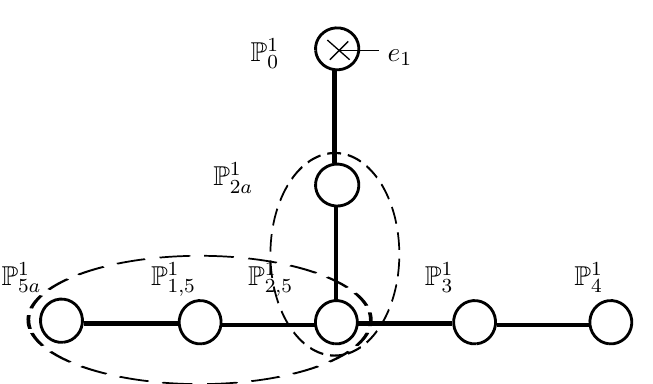
Figure 7 . Extended Dynkin diagram of E 6 at the d 7 = 0 locus. The a(cid:14)ne node has an intersection with [ e 1 ]. The dashed ellipses indicate SO(10) nodes before the matter